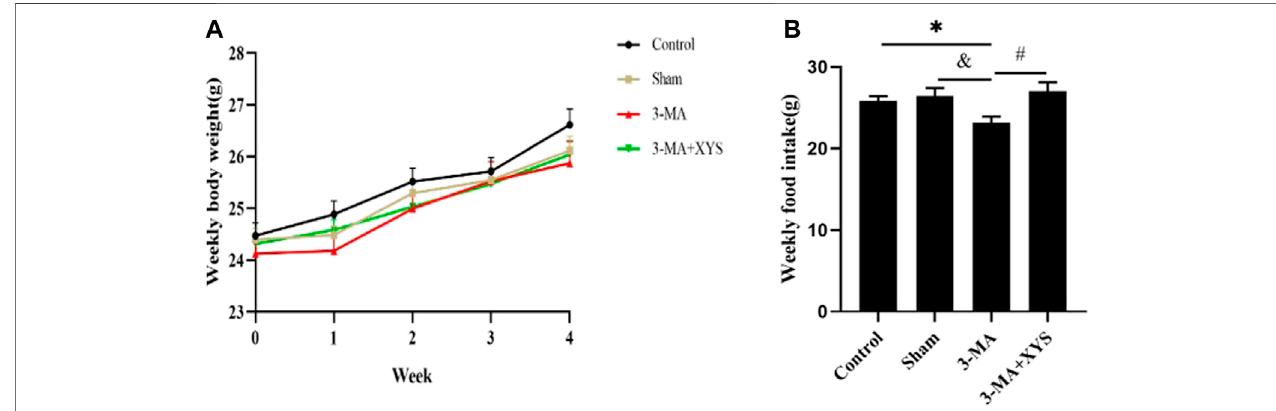
FIGURE6| Effectsof3-MAandXiaoyaosanontheweeklybodyweightgainanddailyfoodintakeofthemice. (A) Weeklybodyweight(F(3,56)=1.689, p =0.1797, n=15). (B) Weeklyfoodintake(F(3,8)=4.002, p =0.0518,n=15).Thevaluesshownrepresentthemean±SEM. p p < 0.05comparedwiththecontrolgroup.& p < 0.05 compared with the 3-MA group. # p < 0.05 compared with the 3-MA